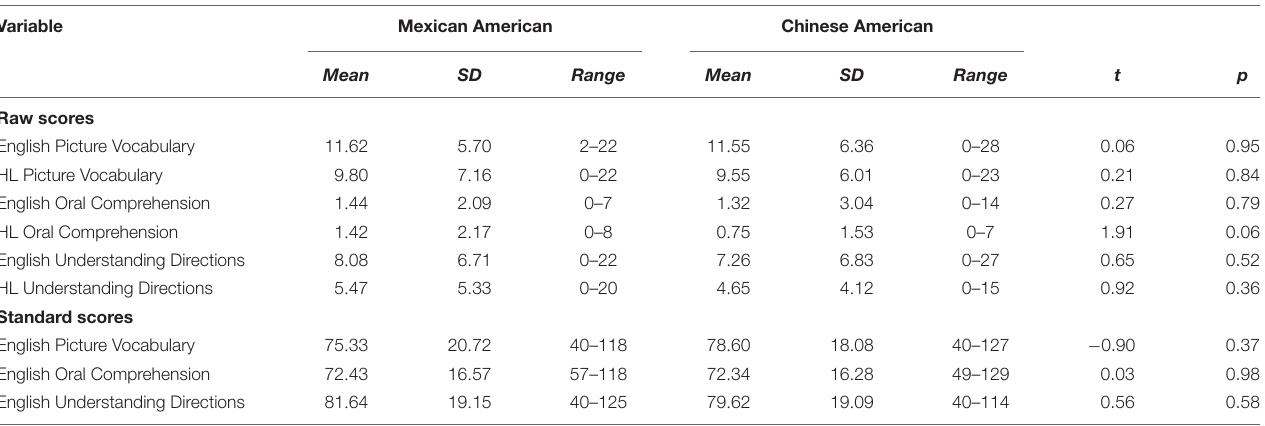
TABLE 4 | Child oral language achievement scores by Mexican American and Chinese American.